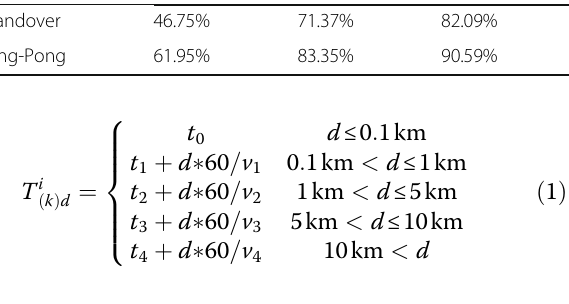
Table 4 Distance distribution comparison of handover and Ping-Pang handover Distance